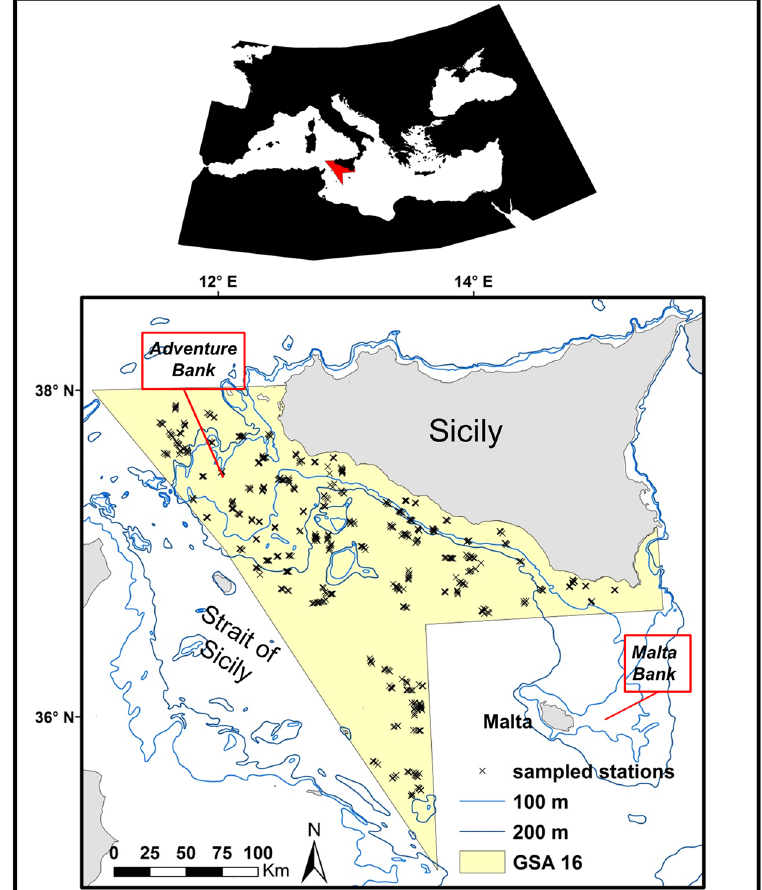
Figure 1. Location of the study region within the Strait of Sicily (Central Mediterranean Sea). This area corresponds to the Geographic Sub Area (GSA) 16. Trawl stations sampled during the MEDITS Survey (2008–2013) are indicated with an x. This map was created with ArcGIS version 10.3 http://www.esriitalia.it by Valentina